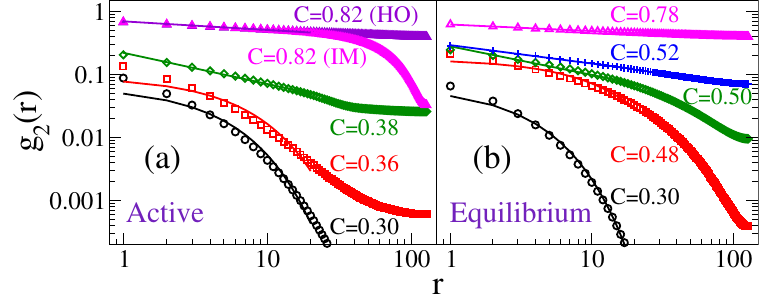
Figure 5. Two-point orientation correlation shown for βε = 2.0 on log-log scale. ( a ) Active model: g 2 ( r ) decays exponentially at low density ( ○ , ◽ ) and algebraically at high density ( ◊ , Δ ). In the bistable regime at high density ( Δ ), g 2 ( r ) decays algebraically in the HO state and abruptly in the IM state. ( b ) Equilibrium model: g 2 ( r ) decays exponentially at low density ( ○ , ◽ ) and algebraically at high density ( ◊ , + , Δ ). Continuous lines are the respective fits, fitted for more than one